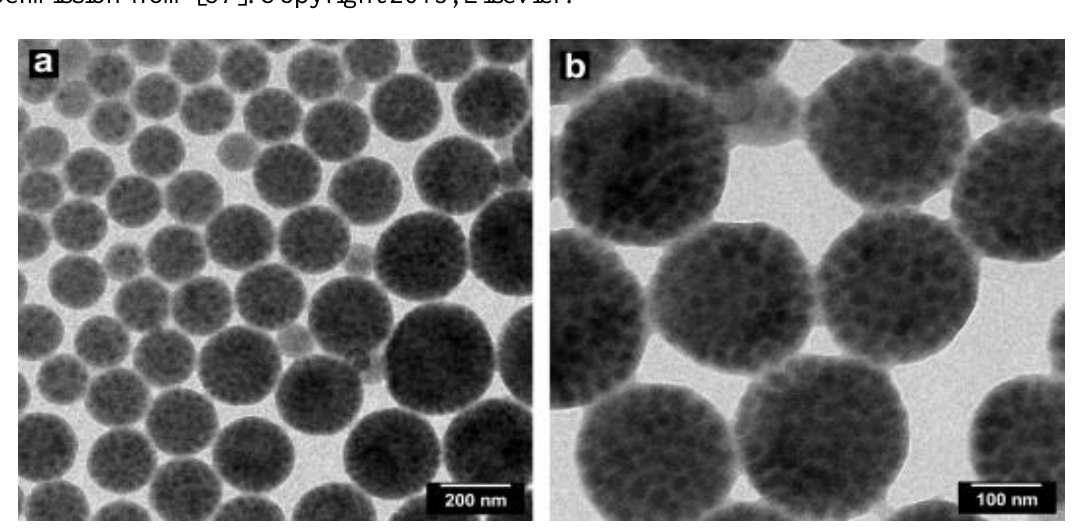
Figure 7. Morphology of hybrid particles with 40 wt% silica and good size distribution. Panels ( a ) and ( b ) show TEM images at different magnifications. Reprinted with permission from [57]. Copyright 2013,